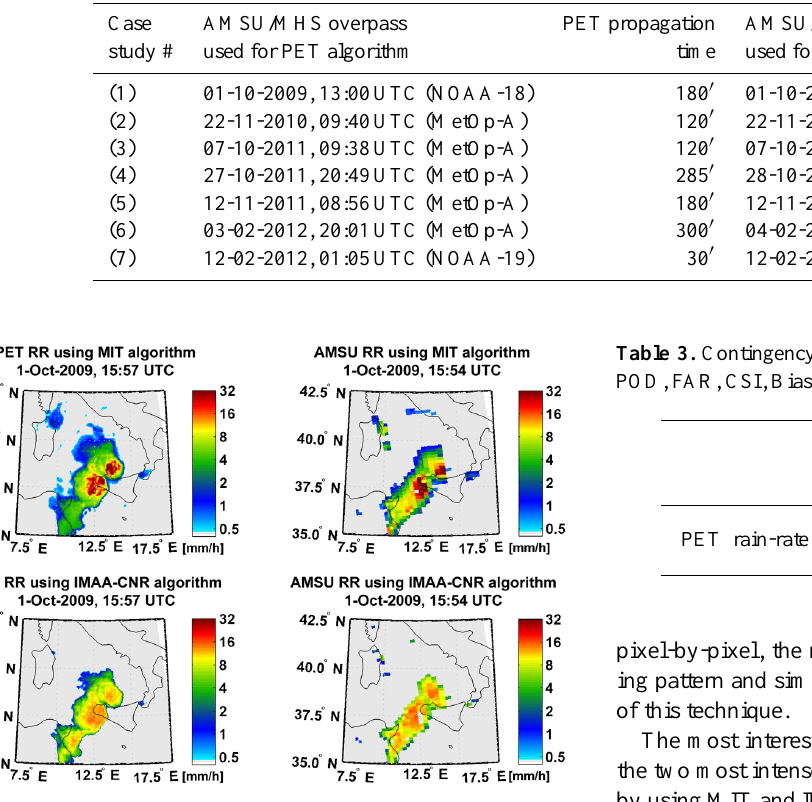
Fig. 6. Case study (1) – Comparison between PET rain-rate es- timates obtained using both MIT and IMAA-CNR algorithm and closest corresponding AMSU/MHS-based rain-rate estimates. Gray area denotes first AMSU/MHS overpass.